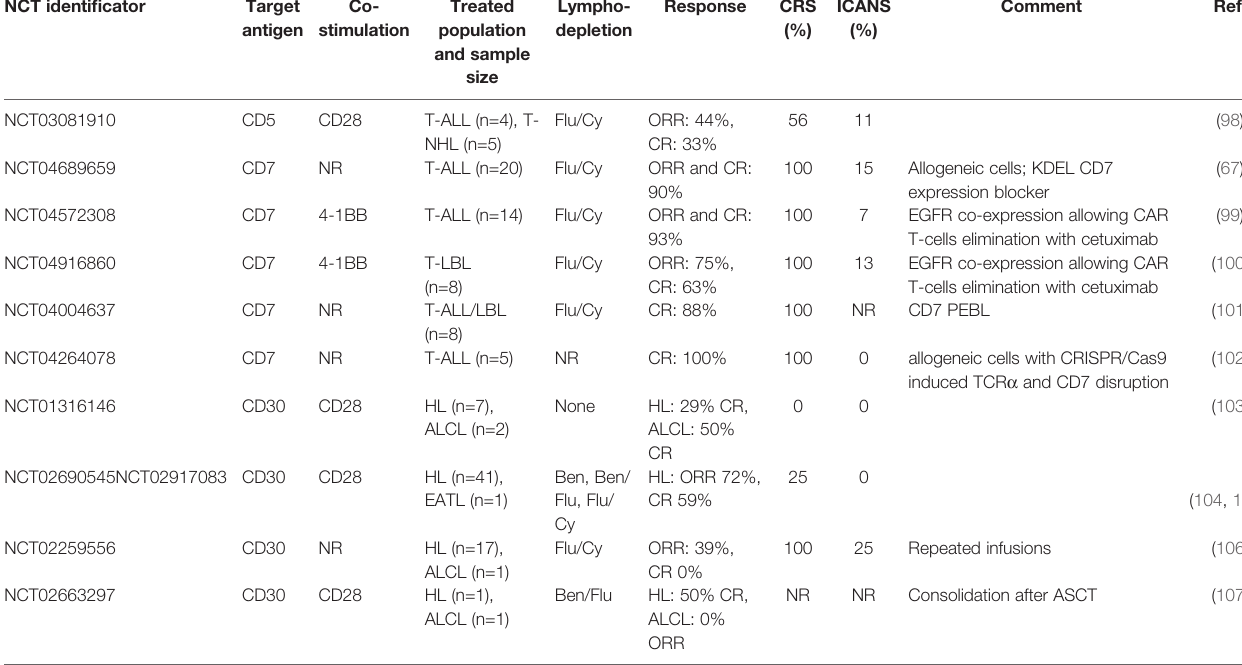
TABLE 4 | Trials using CAR-T cells technology targeting T-cell malignancies with their corresponding results. NCT identi fi